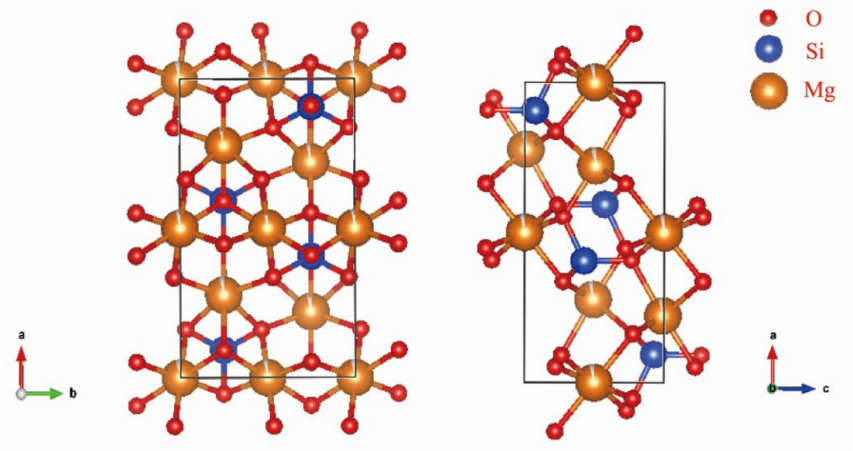
Figure 3. Unit-cell of B-rich forsterite structure viewed along c and b